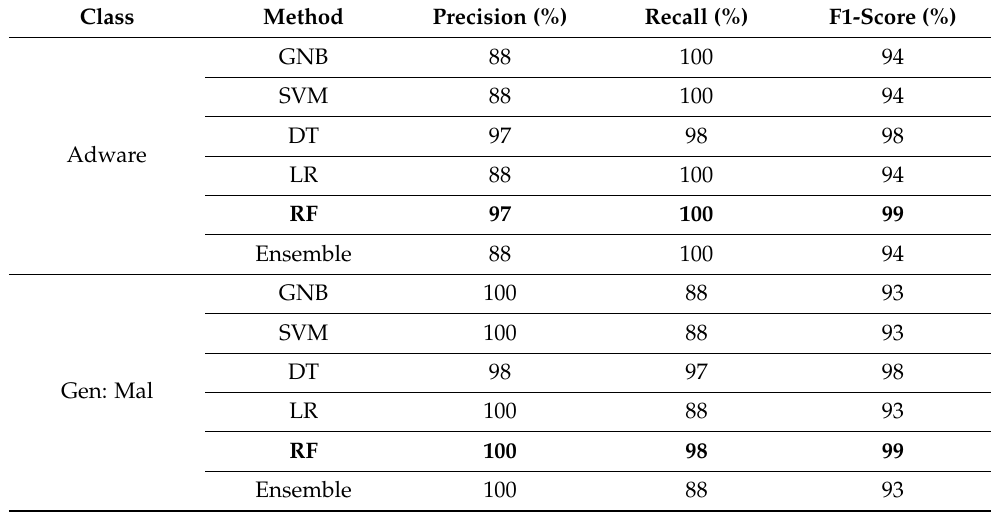
Table 6. Per-class performance comparisons for malware classification using dataset 1 with 256 ×